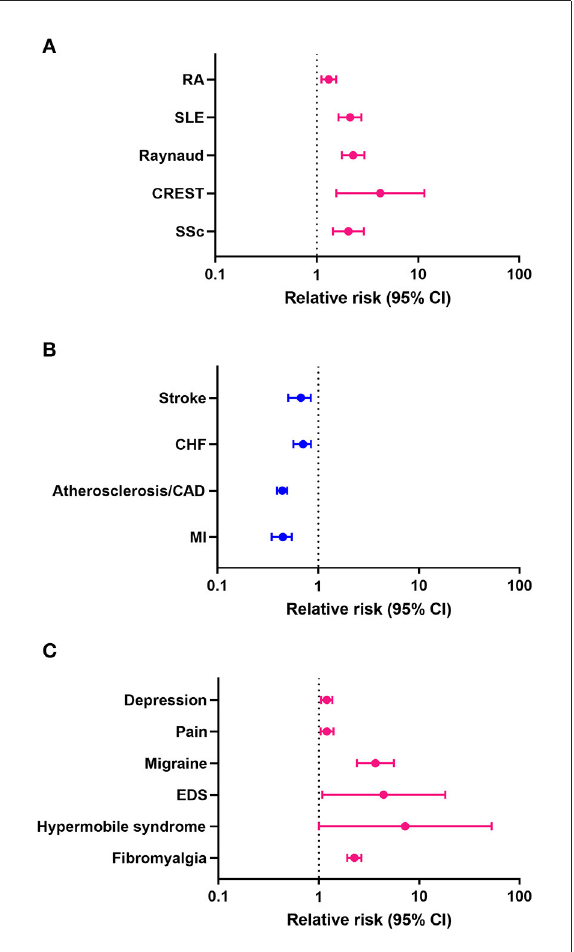
FIGURE1 Relative risk (hazard ratio) of comorbidities in patients with Sjögren’s disease ( n = 13,849). ( A ) Rheumatic autoimmune diseases/syndromes, ( B ) cardiovascular diseases, ( C ) pain-related conditions; pink indicates increased risk in women, blue increased risk in